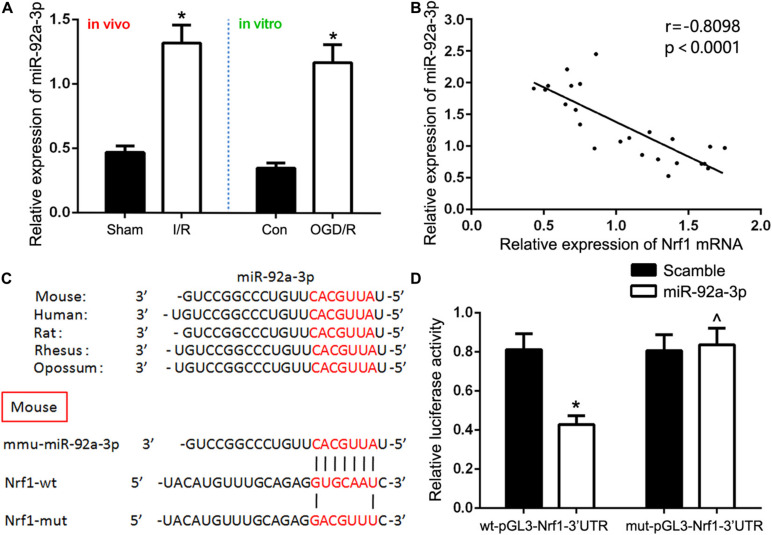
Nrf1 is a direct target of miR-92a-3p. (A) qRT-PCR analysis of miR-92a-3p expression in vivo and in vitro. (B) Pearson’s correlation analysis revealed that the mRNA expression of miR-92a-3p was inversely correlated with the expression of Nrf1. (C) Database predicted the existence of binding sites between Nrf1 3(UTR and miR-92a-3p. (D) Dual-reporter luciferase assay of miR-92a-3p expression in wt-pGL3-Nrf1-3(UTR or mut-pGL3-Nrf1-3(UTR constructs. Data are expressed as the mean ± SD. n = 6 per group in vivo and n = 3 per group in vitro. *P < 0.05 vs. sham, control, and wt-pGL3-Nrf1-3′UTR group. ∧P < 0.05 vs. mut-pGL3-Nrf1-3′UTR group, one-way ANOVA.